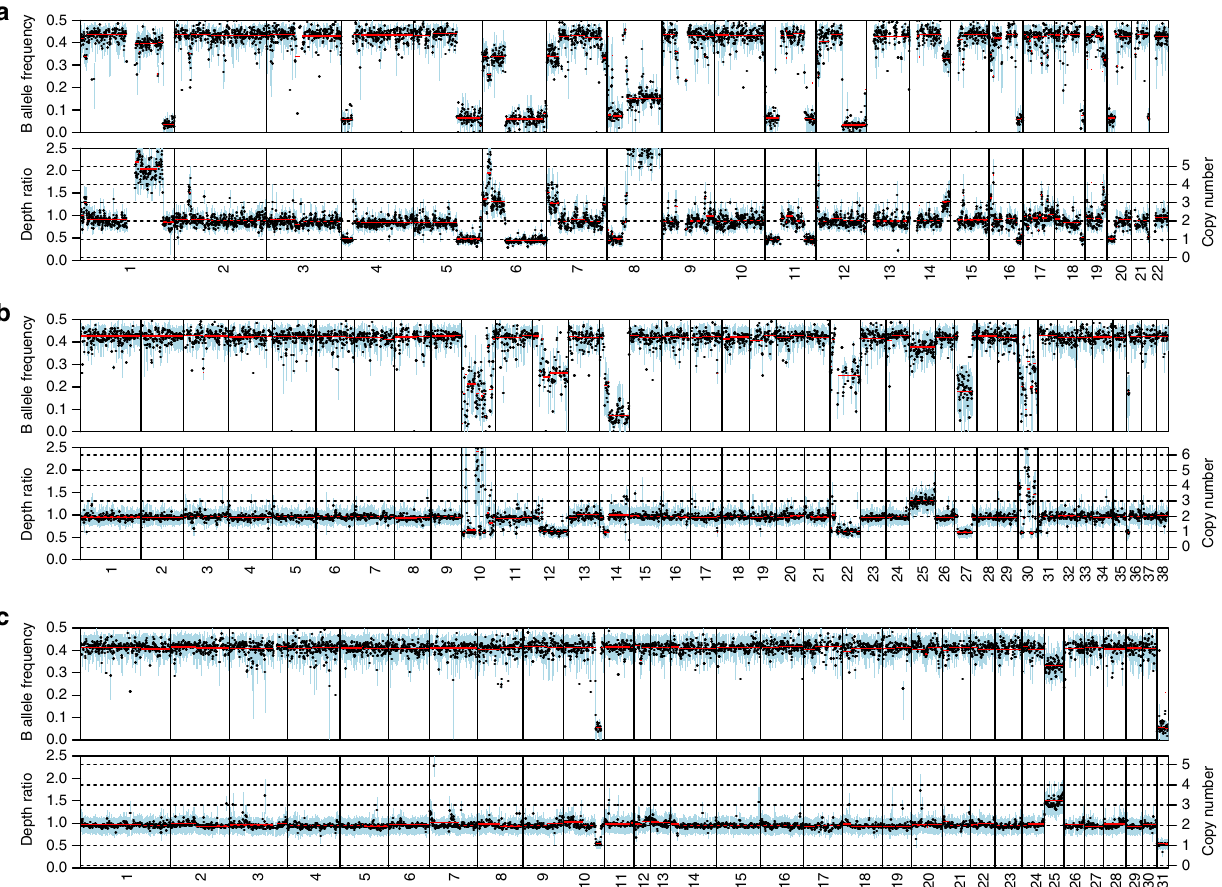
Fig. 4 Copy number pro fi les of individual melanoma samples. a A representative copy number pro fi le of a human mucosal melanoma from the nasal sinus (PD26997a). This case had copy number gains of 1q, 6p and 8q, and loss of 6q, 8p, all of which are known recurrent events in mucosal melanoma 38 . b A copy number pro fi le of a representative canine oral melanoma (DD0068a), with complex copy number pro fi les on chromosomes 10 and 30, loss of chromosomes 12, 22, 27, and gain of chromosome 25. c A representative copy number pro fi le of an equine mucosal-like melanoma from the prepuce (HD0081a). This sample harbors both a gain of chromosome 25 and loss of chromosome 31, which were frequently observed (although not necessarily together) in the equine cases from mucosal-like